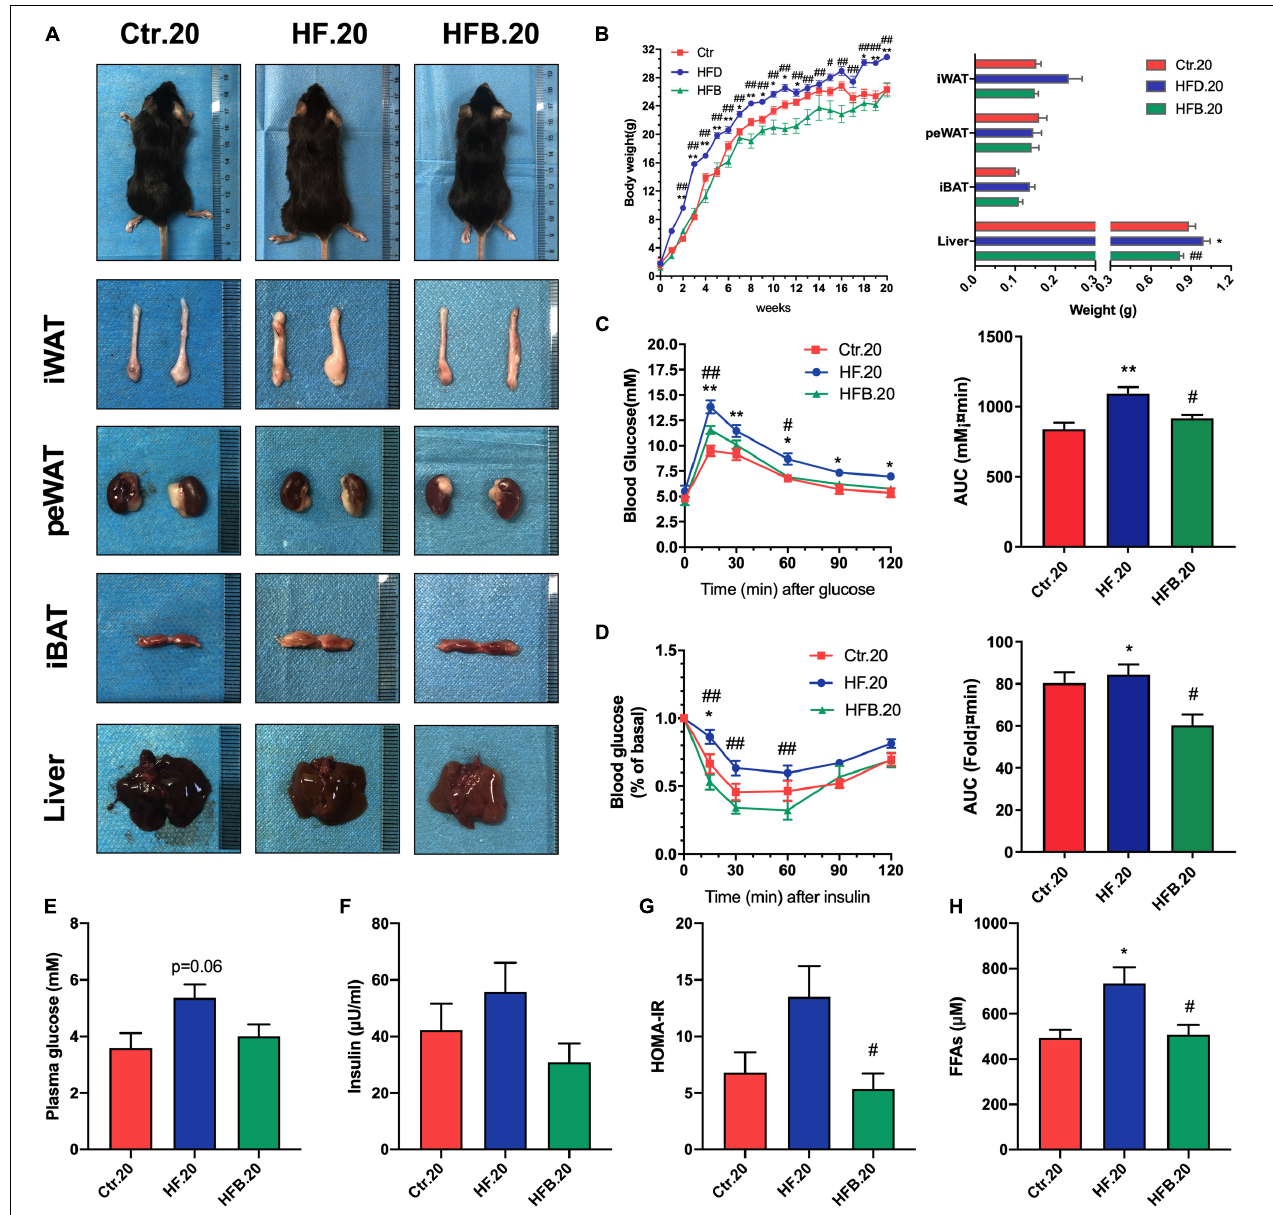
FIGURE 5 | Maternal betaine protects 20-week-old offspring from glucose and lipid metabolic disorders induced by early-life high-fat diet. Offspring mice were analyzed at 20 weeks of age. (A) General picture of body composition; (B) body weight (left) and body composition (right) changes; (C) oral glucose tolerance test (left) and the area under the curve (right); (D) insulin tolerance test (left) and the area under the curve (right); (E) fasting plasma glucose; (F) fasting insulin level; (G) HOMA-IR; (H) FFAs. Ctr.20, 20-week-old offspring of dams fed with the standard control diet; HF.20, 20-week-old offspring of dams fed with the high-fat diet; HFB.20, 20-week-old offspring of dams fed with the high-fat diet with betaine. HOMA-IR, homeostasis model assessment of insulin resistance; FFAs, free fatty acids. Data are expressed as means ± S.E.M. ( n = 5–8/group). One-way and two-way ANOVA; ** p < 0.01 vs. Ctr, # p < 0.05 vs. HF.